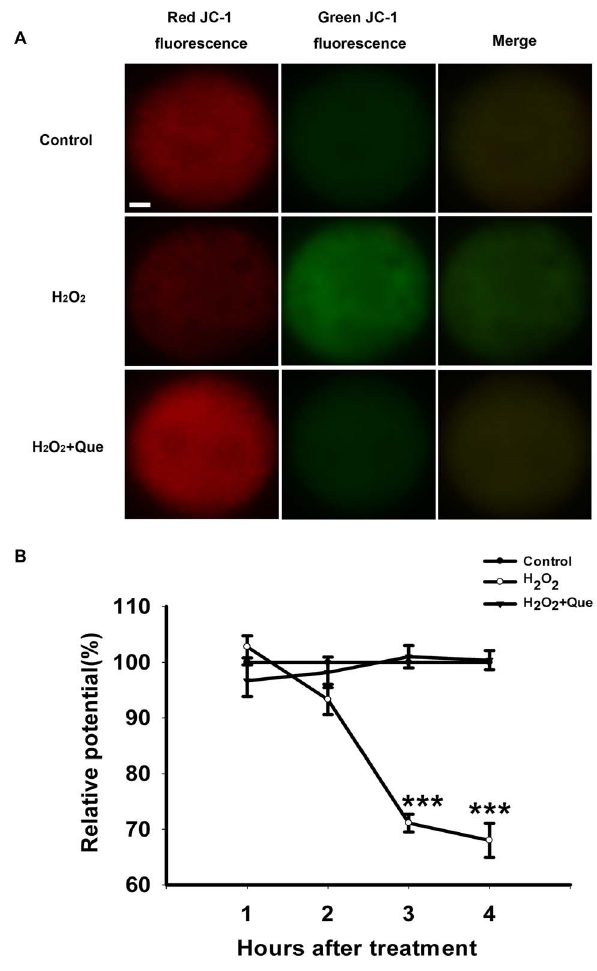
Figure 4. Quercetin prevented mitochondrial dysfunction induced by H 2 O 2 in mouse zygotes. (A) Representative photomi- crographs of inner mitochondrial membrane potential (MMP) in mouse zygotes 3 hours later after treated with H 2 O 2 or H 2 O 2 plus Que. Zygotes was stained with JC-1. Red fluorescence represented J-aggregates (high polarized mitochondria) and green fluorescence represented monomer form of JC-1 (low polarized mitochondria). Bar, 10 m m. (B) The ratios of intensity of red /green fluorescence (MMP) were analyzed from the images. The average of MMP from zygotes in the control group at each time point was set at 100%, and the MMP in treated zygotes were expressed relative to that of zygotes in the control group at each time point. MMP in zygotes declined 2 hours later after treatment of 35 m M H 2 O 2 for 15 min and continued to drop over the subsequent hours. Quercetin can maintain MMP at the similar level of the control group. Data are presented as mean 6 SEM from three independent experiments. *** P , 0.001 compared with the control group (One-way ANOVA, n=15 for each group).